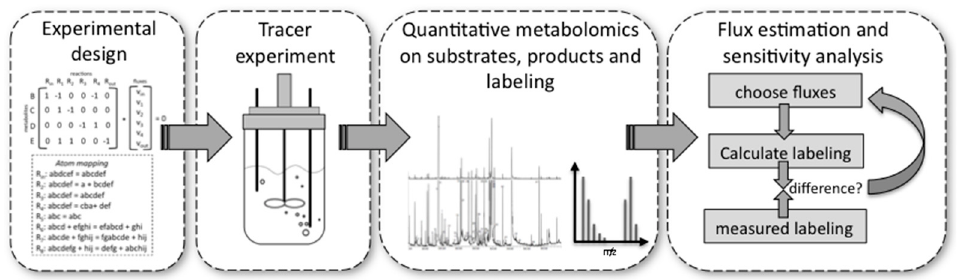
Figure 4. Workflow of a typical 13 C metabolic flux analysis experiment.